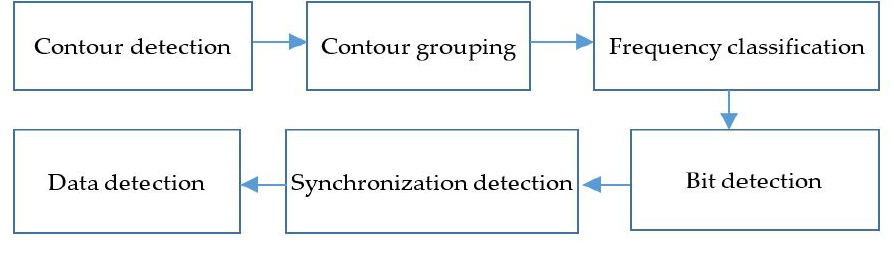
Figure 10. Data decoding processes.